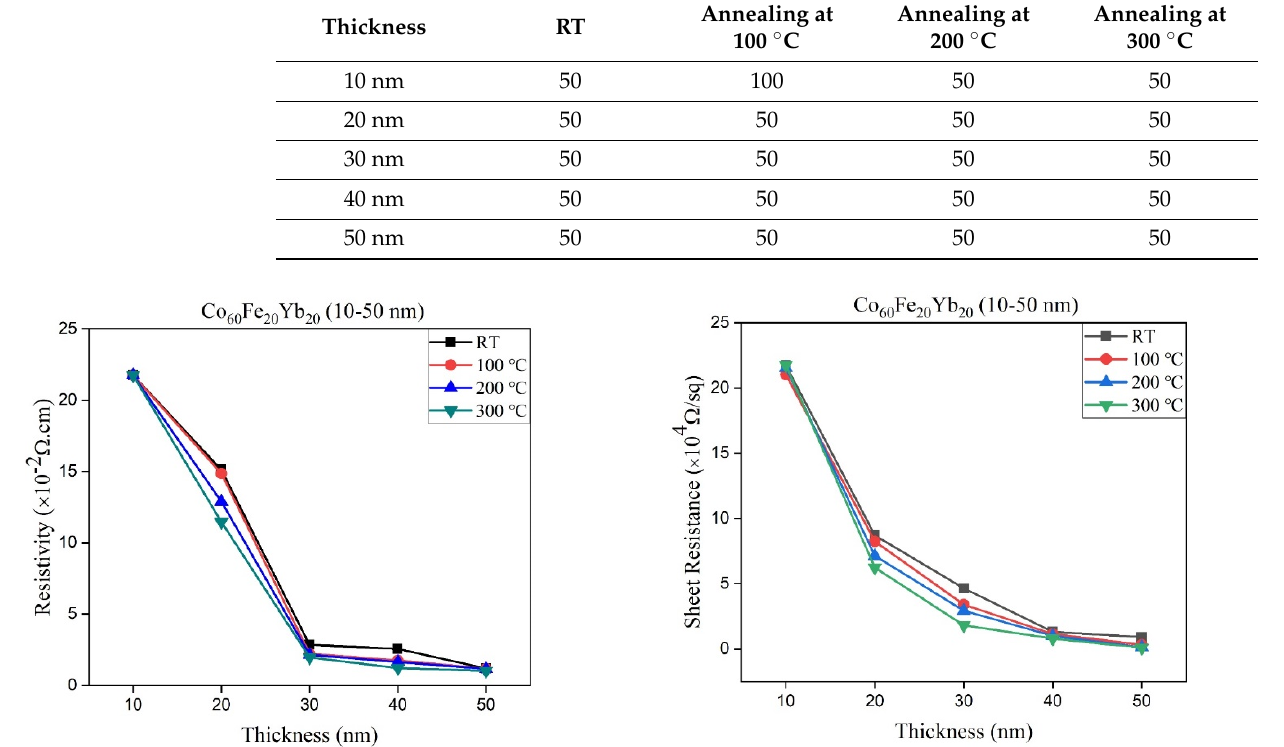
Table 2. The optimal resonant frequency for various thicknesses.